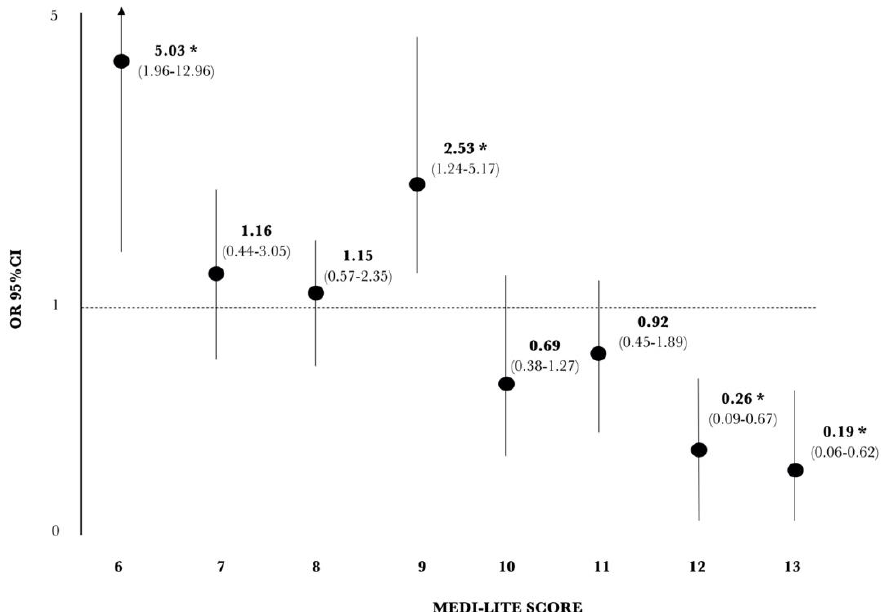
Figure 2. Logistic regression analysis for the risk of abdominal obesity according to the Medi-Lite score; * p < 0.05 adjusted for age and gender.